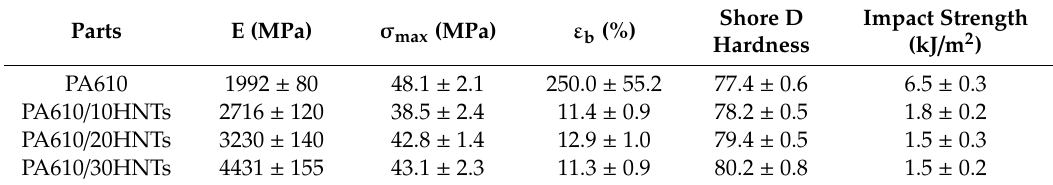
Table 2. Summary of mechanical properties of the injection-molded parts of polyamide610 (PA610) with HNTs, in terms of: tensile modulus (E), maximum tensile strength ( σ max ), and elongation at break ( ε b ), Shore D hardness, and impact strength. Parts E